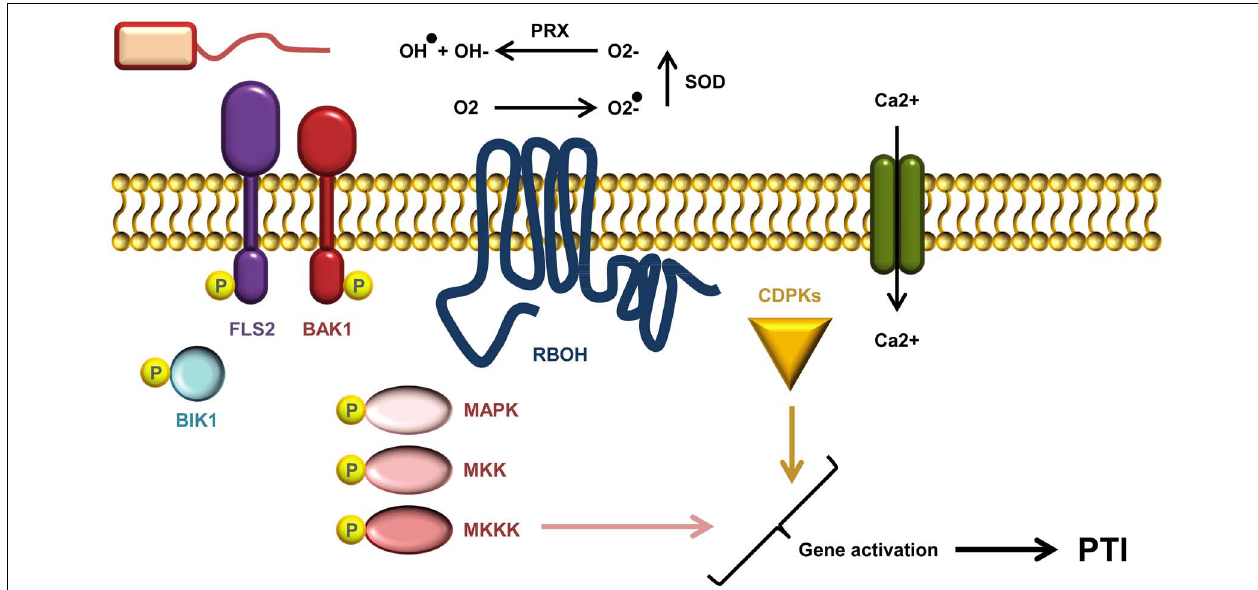
FIGURE 2 |A current model of AtFLS2 signaling. Upon flg22 binding, a complex between FLS2, BIK1, BAK1 (and other SERKs) is formed. Complex formation triggers multiple rapid phosphorylation events resulting in BIK1 release. The signal transduction downstream of